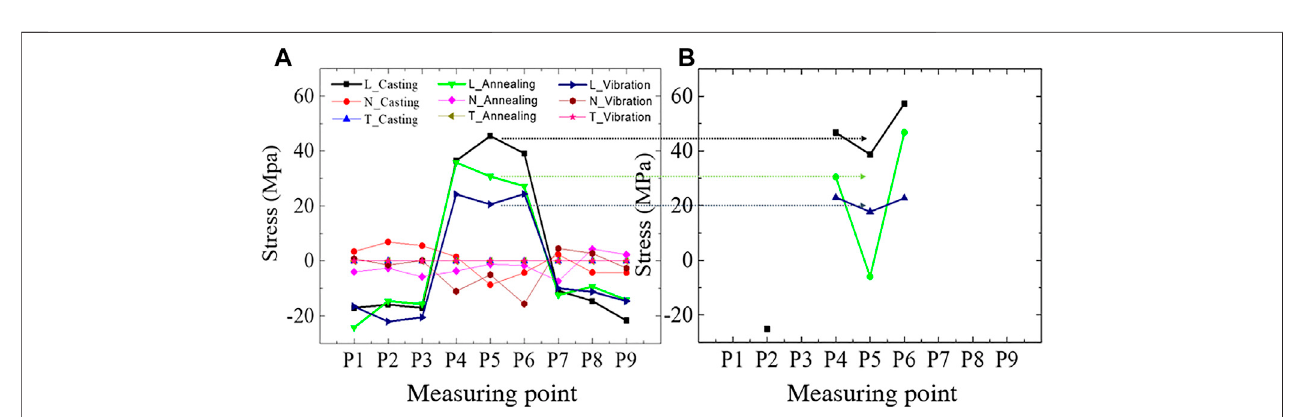
FIGURE4| Averagestressinthestressframeofthegrayironalongthethreeorthogonaldirectionsprobedwiththeneutrondiffractiontechnique (A) beforeand (B) after cycling heating